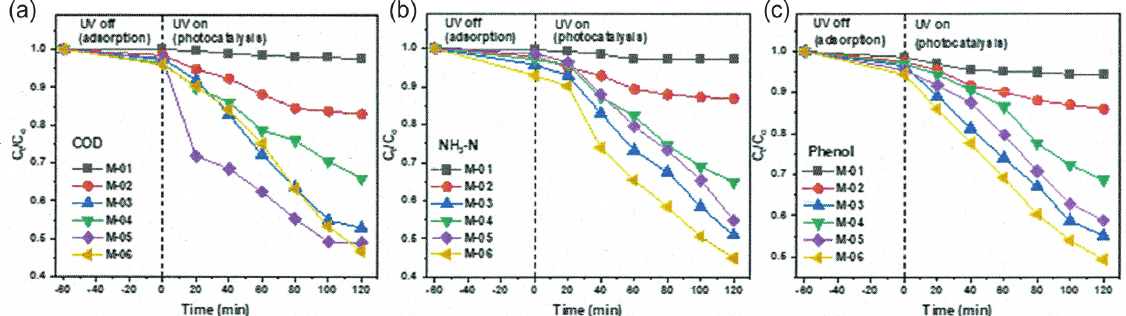
Figure 26. Concentration in relation to the initial concentration of COD ( a ), NH 3 -N ( b ) and phenol ( c ) in petroleum refinery wastewater after purification with a photocatalytic membrane without and with UV irradiation. The different membranes were coated with only SiO 2 (M-02), only TiO 2 (M-03), only Co/SiO 2 (M-04), only TiO 2 @SiO 2 (M-05), with Co-TiO 2 @SiO 2 (M-06) and without any particles (M-01). (Reprinted/adapted with permission from Ref.